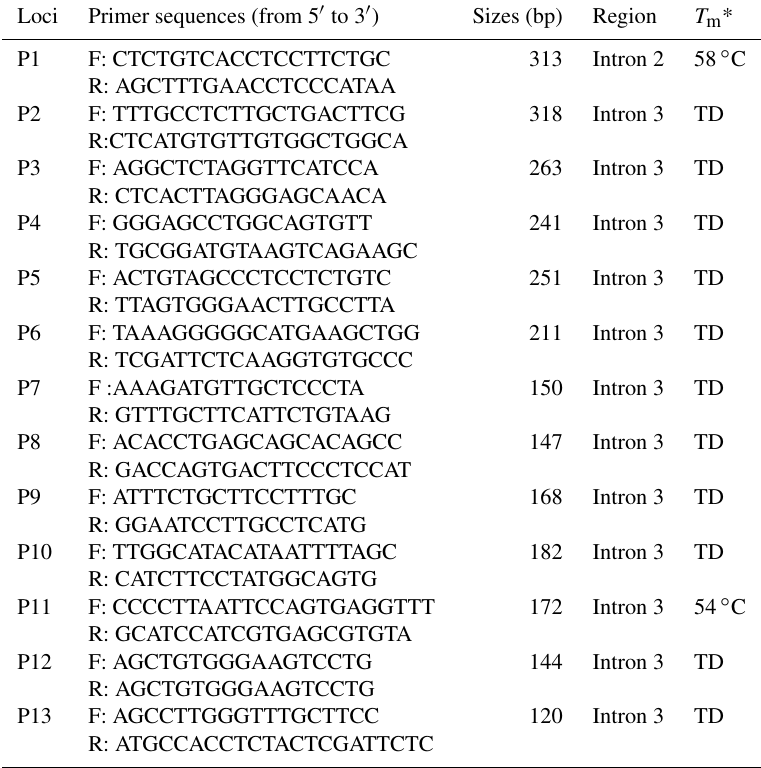
Table 1. PCR primer sequences of the goat ZFXH3 gene for amplification. Loci Primer sequences (from 5 (cid:48) to 3 (cid:48) ) Sizes (bp) Region T m